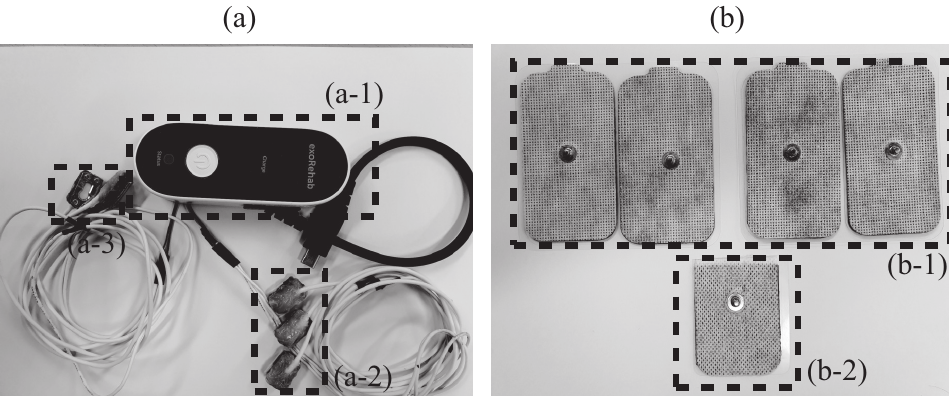
Figure 5. Equipment for experiment. ( a ) Device for the ES, (a-1) Main device, (a-2) Electrode for the EMG, (a-3) Electrode for the ES, ( b ) Electrode pads, (b-1) Electrode for the ES and EMG, and (b-2) Electrode for